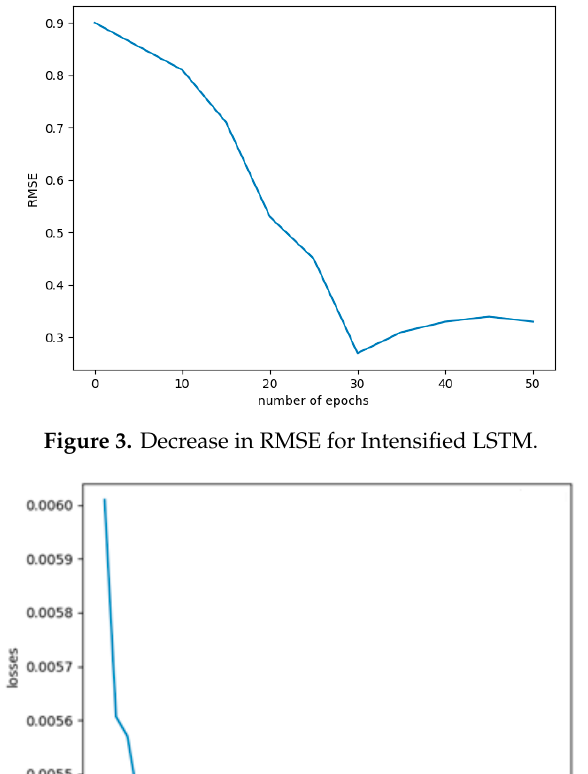
Figure 5. Gradual decrease in Learning rate for Intensified LSTM. The initial learning rate is fixed to 0.1 which is the value used to multiply with the weight for weight adjustment. It was expected that network loss would be minimized to certain level as the number of epochs are increased. As expected, loss subsided, and in turn, the learning rate value also diminished. An optimized level was reached at around the 30 th epoch in both network loss and error, but learning rate value was around 0.04, and accuracy was around 83% at this stage. To trace out a better improvement, the network was trained further up to 40 epochs, which led to a better learning rate at 0.025, after which there was an oscillation in losses without a drastic change, which is shown in Figures 4–6.